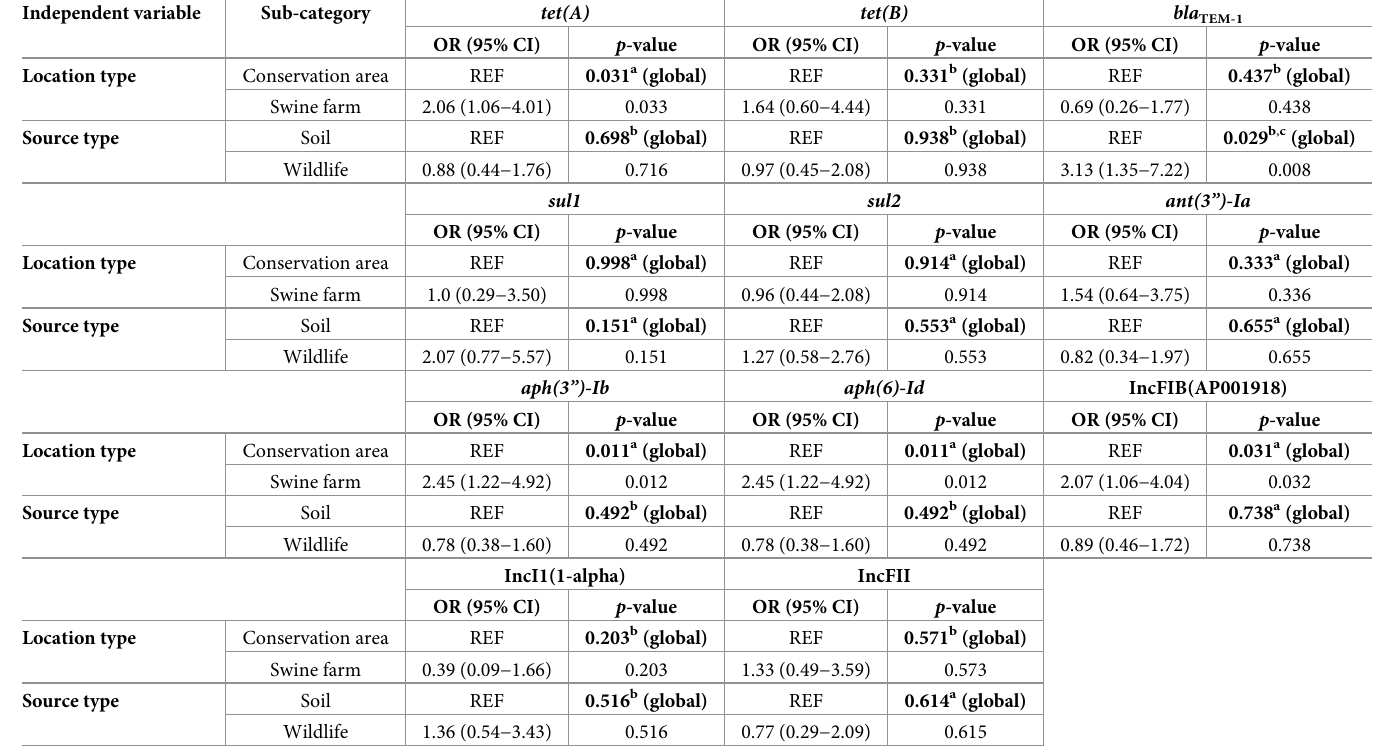
Table 7. Logistic regression models a,b,c assessing the association between source type, location type, and the occurrence of select plasmid incompatibility types and antimicrobial resistance genes in phenotypically resistant Escherichia coli isolates from wildlife and soil samples collected on swine farms and conservation areas in southern Ontario, 2011 − 2013 (n = 146, dataset